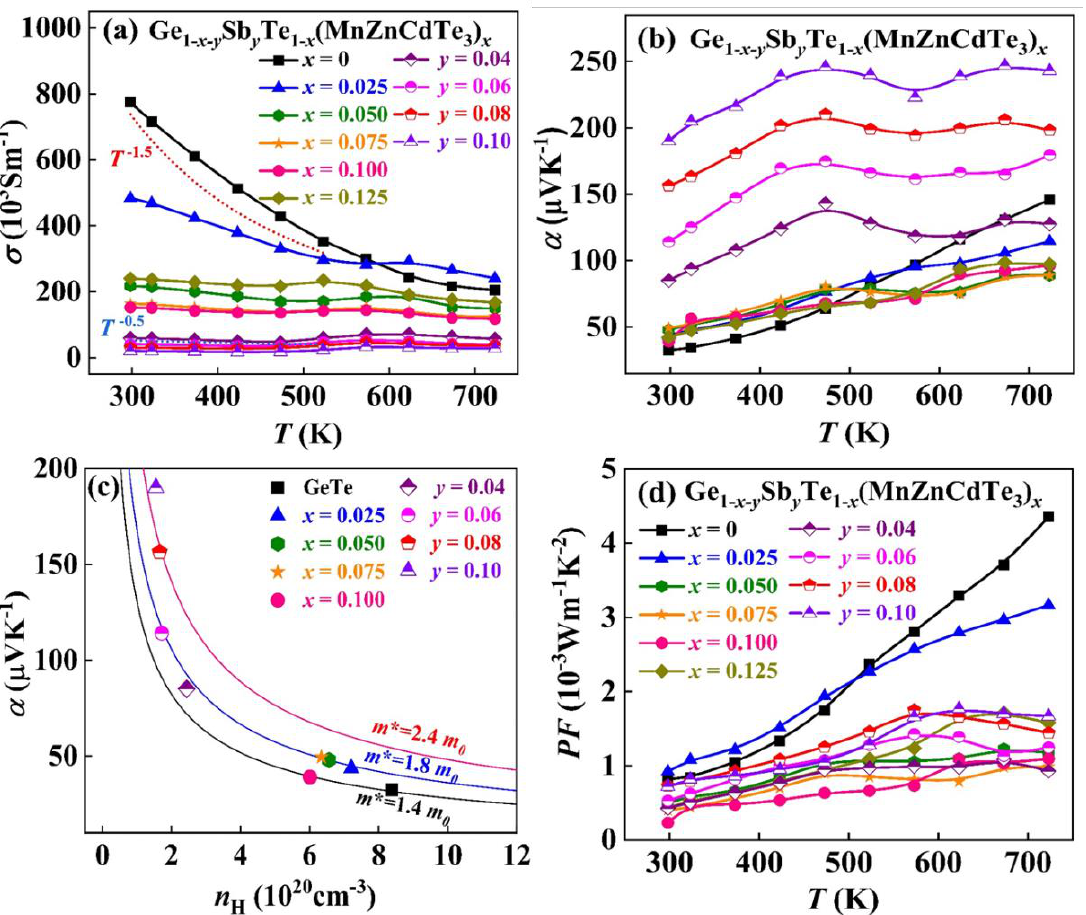
Figure 4. Temperature dependence of ( a ) electrical conductivity σ , ( b ) Seebeck coefficient α , and ( d ) power factor PF for (GeTe) 1− x (MnZnCdTe 3 ) x and Ge 0.82 − y Sb y Te 0.90 (MnZnCdTe 3 ) 0.10 samples. ( c ) Room temperature Seebeck coefficient α as a function of carrier concentration n H for Ge 1− x − y Sb y Te 1− x (MnZnCdTe 3 ) x samples.